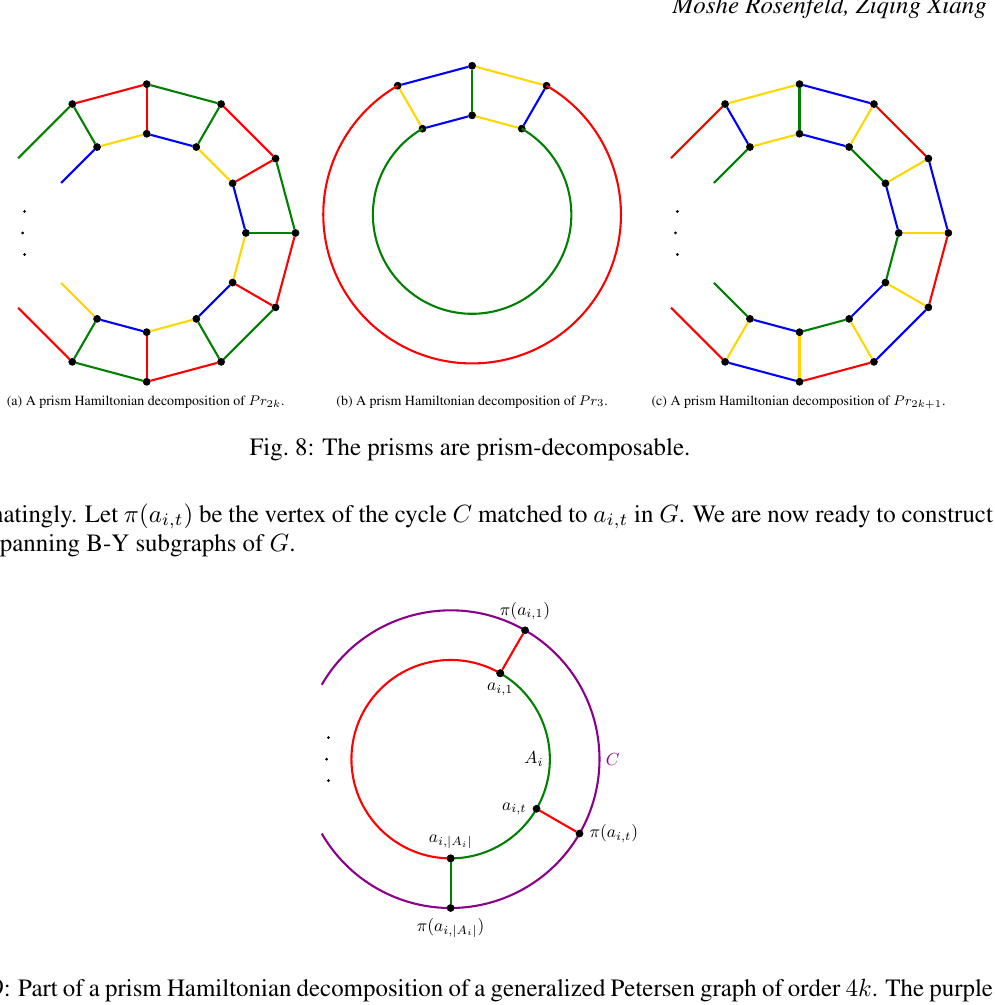
Fig. 9: Part of a prism Hamiltonian decomposition of a generalized Petersen graph of order 4 k . The purple cycle C is a B-Y